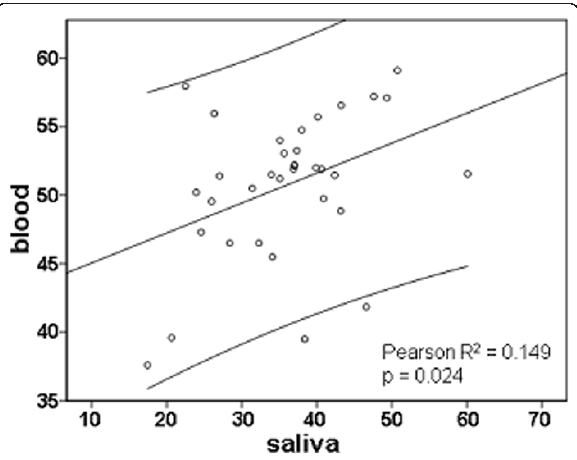
Figure 3 Intra-individual correlation between saliva and blood DNA methylation levels at the S-COMT promoter (mean methylation = (CG1 + CG2)/2))